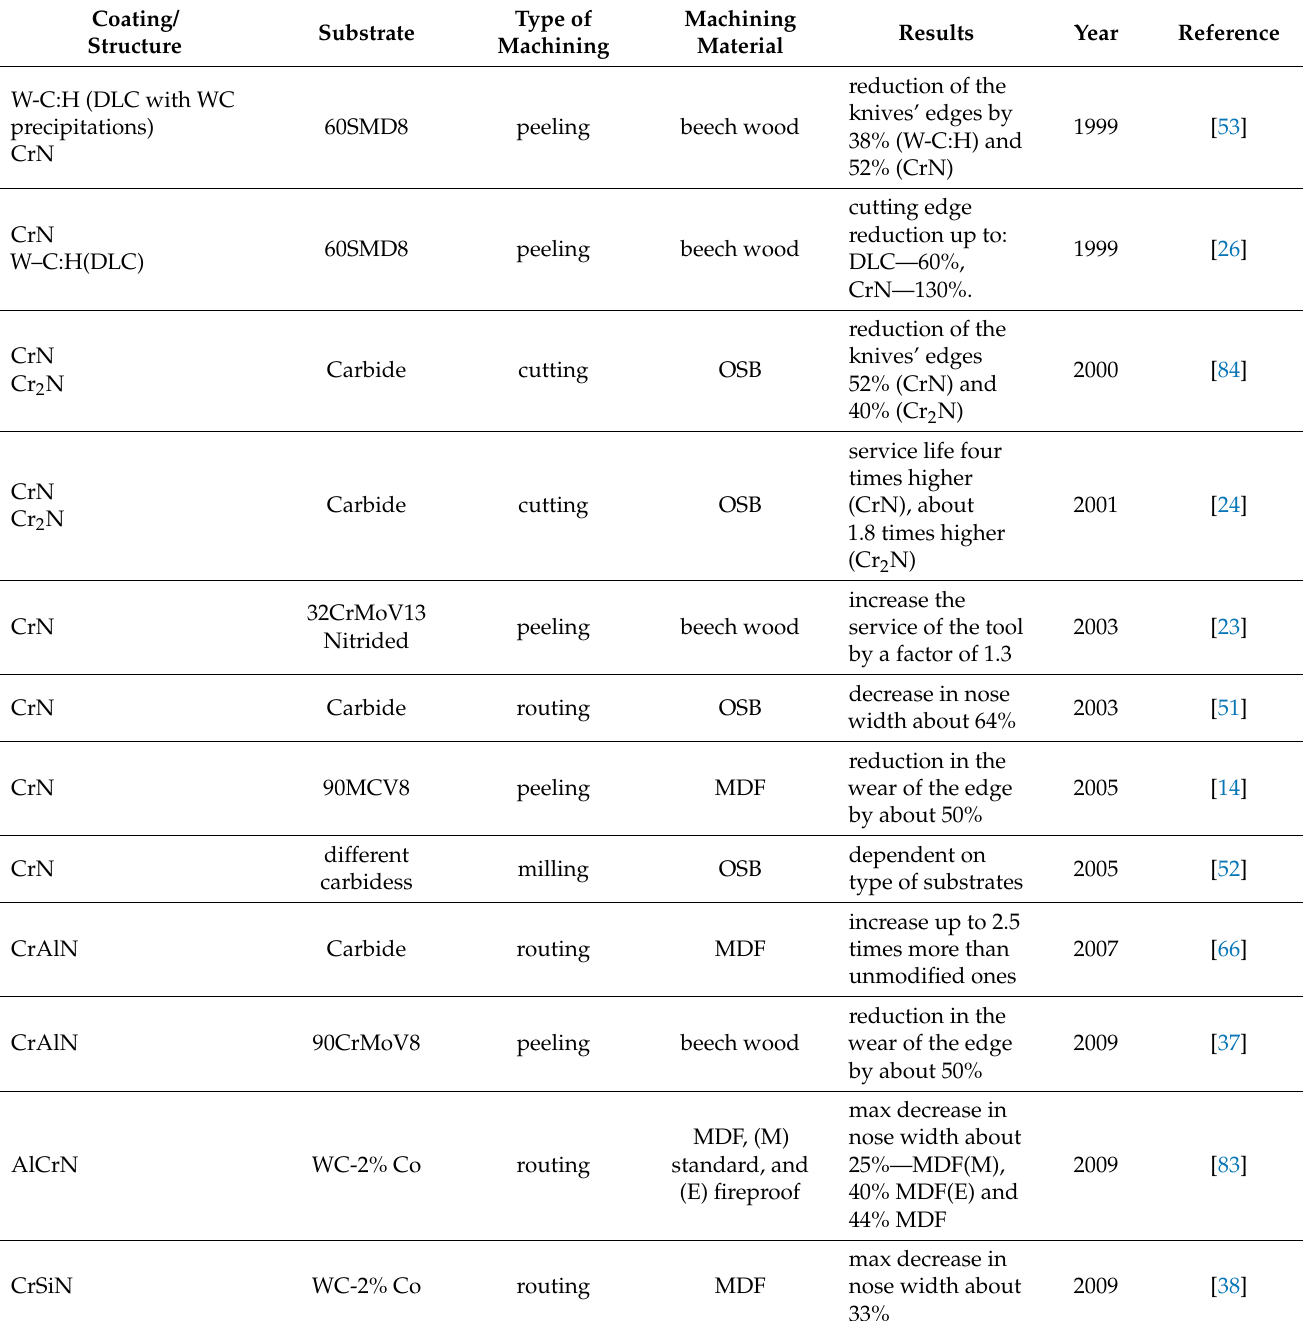
Table A1. Magnetron sputtering. Protective coatings applied to woodworking tools, synthetic information on the coatings used, the materials processed, the type of substrate and the effect of its